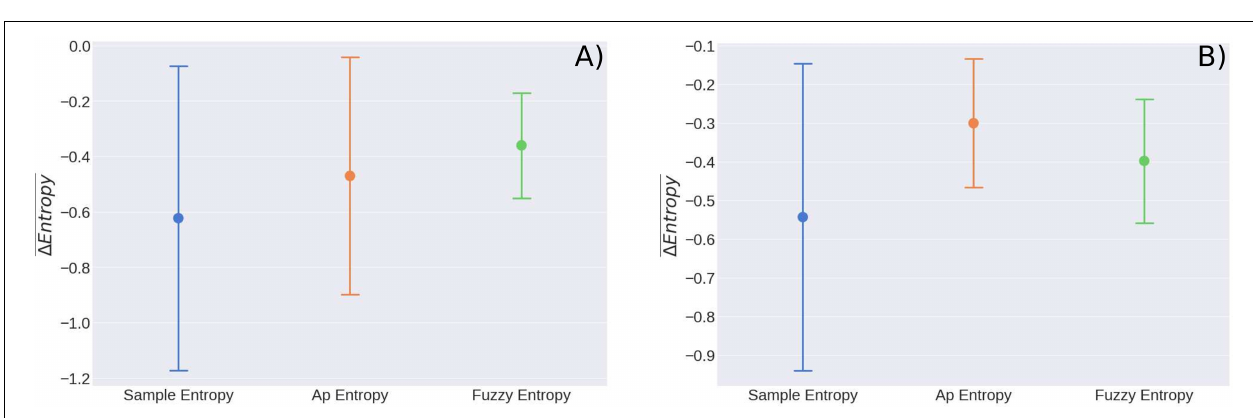
and (cid:49) FuzzyEn = − 0 . 36 ± 0 . 19 and the values for adults with a sedentary lifestyle are (cid:49) SampEn = − 0 . 54 ± 0 . 43, (cid:49) ApEn = − 0 . 3969 ± 0 . 3680, and (cid:49) FuzzyEn = − 0 . 39 ± 0 . 17.